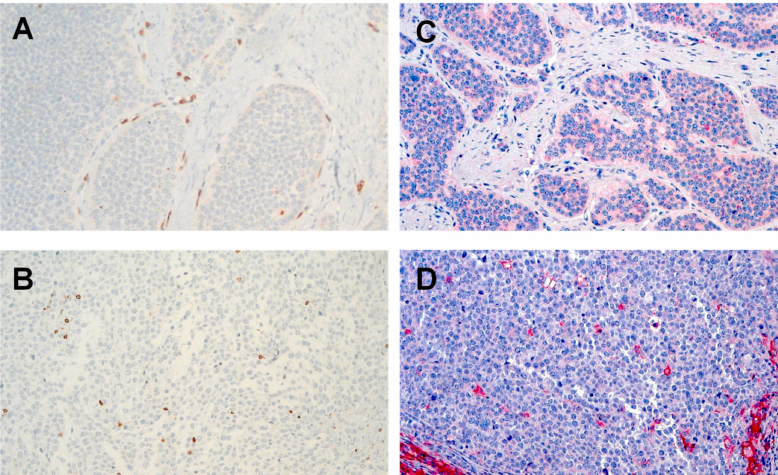
Figure 1. Immunohistochemical staining. ( A ) CD3 in neuroendocrine tumors (NET) G1 / G2 with stromal T cell infiltration 8 / 1 high-power fields (HPF); ( B ) CD3 in NET G3 / neuroendocrine carcinomas (NEC) with intratumoral T cell infiltration 10 / 1 HPF; ( C ) programmed death-ligand 1 (PD-L1) in NET G1 / G2, weak staining in > 1% tumor cells; ( D ) PD-L1 in NET G3 / NEC; strong staining > 1% of tumor cells original magnification × 300. Table 2. Immunohistochemistry results in NETG1 / 2 and NET G3 / NEC. NET G1 / G2 NET G3 /